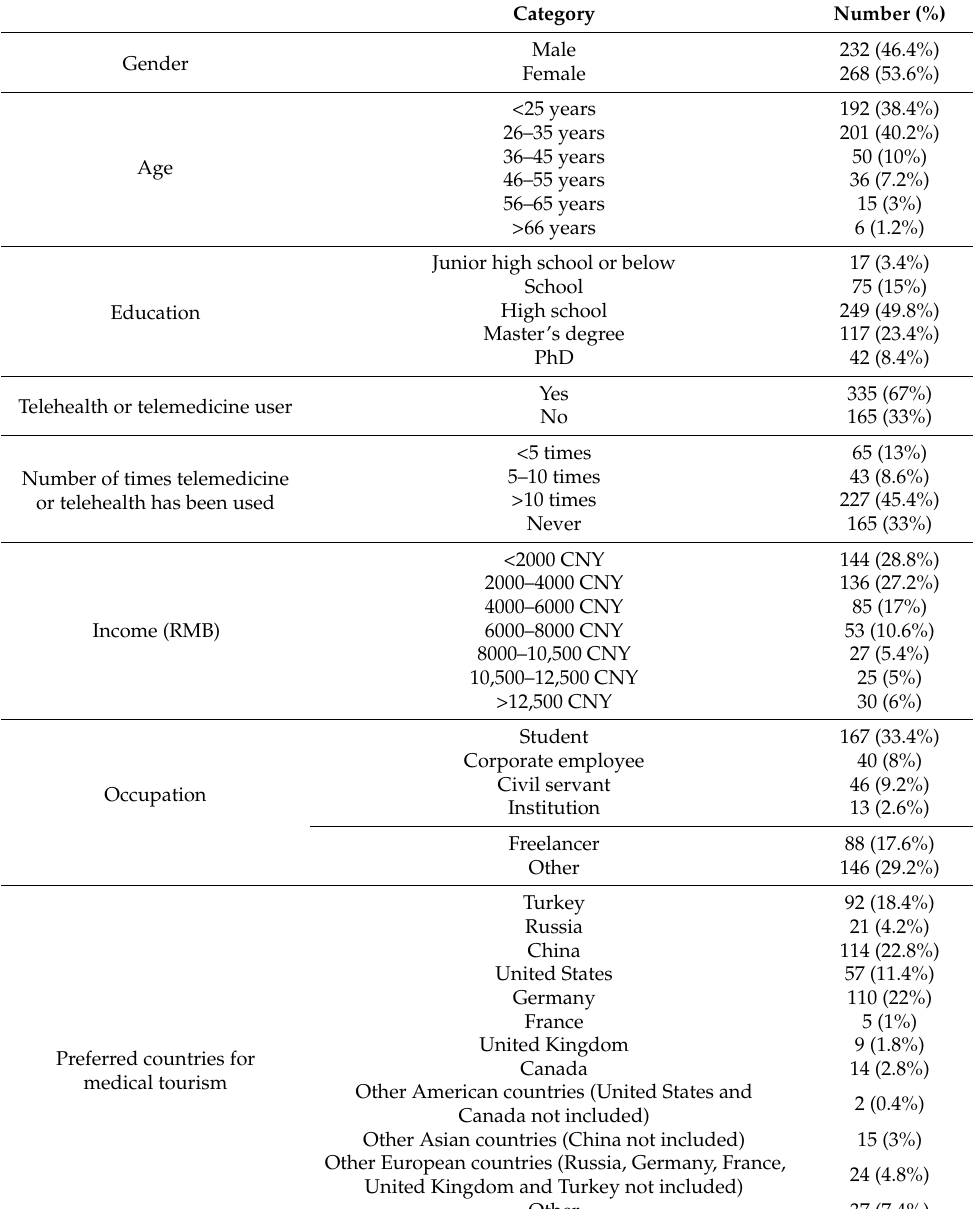
Table 3. Demographics of